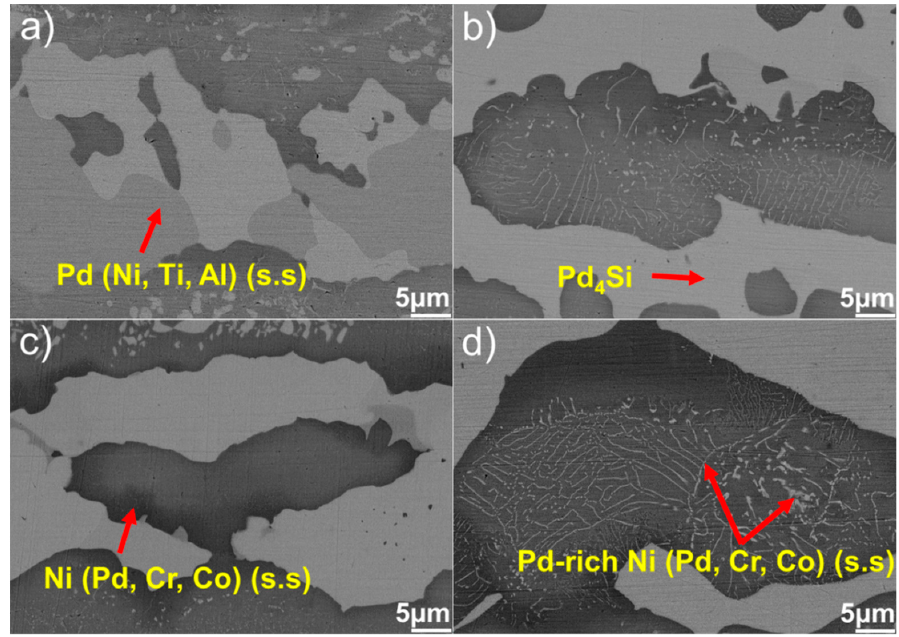
Figure 9. SEM back-scattered electron images of the zone 1 in the DD98M / Pd-Si / DD98M joints brazed at 1060 ◦ C for di ff erent soaking time: ( a ) 10 min, ( b ) 30 min, ( c ) 60 min, and ( d ) 90